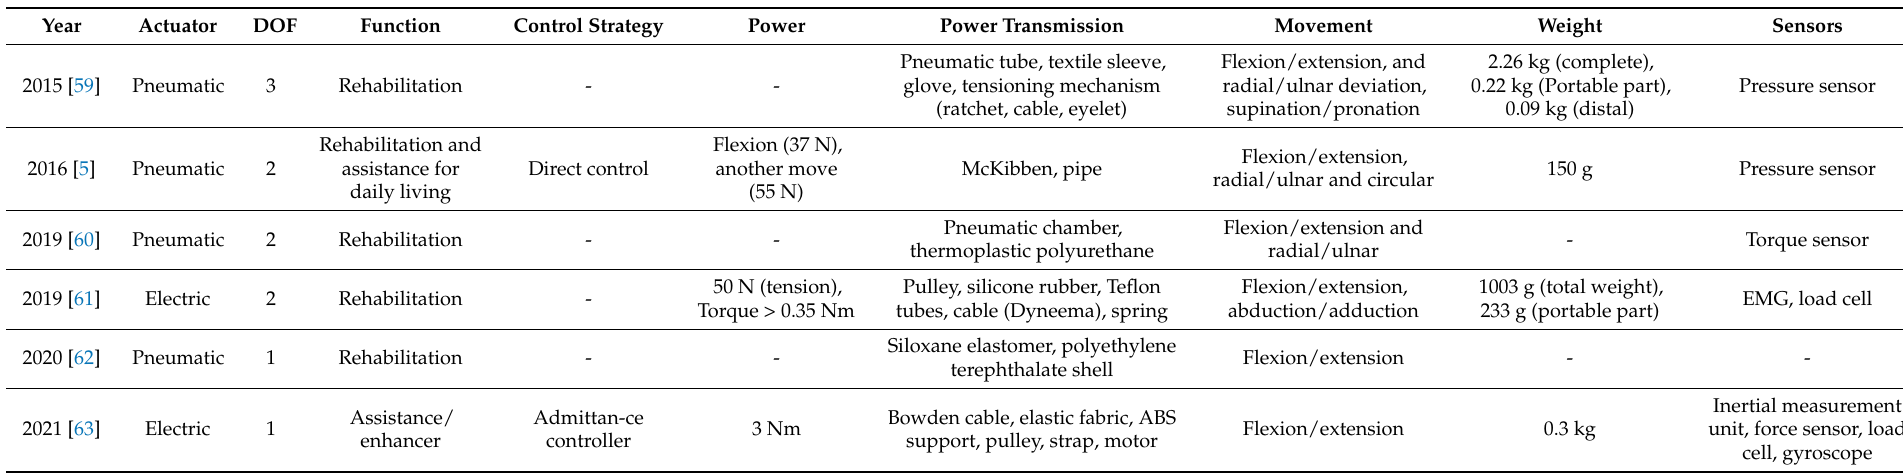
Table 3. Development of soft exoskeletons for the wrist.